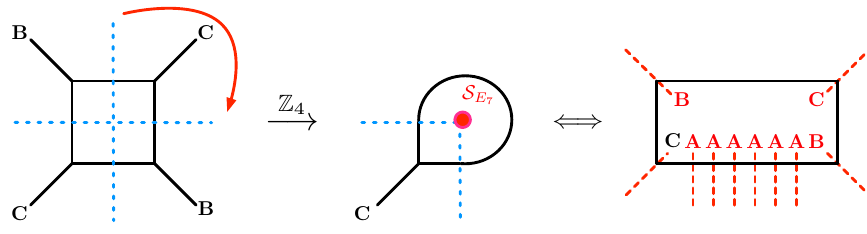
= A 6 BCB at the center of the 7